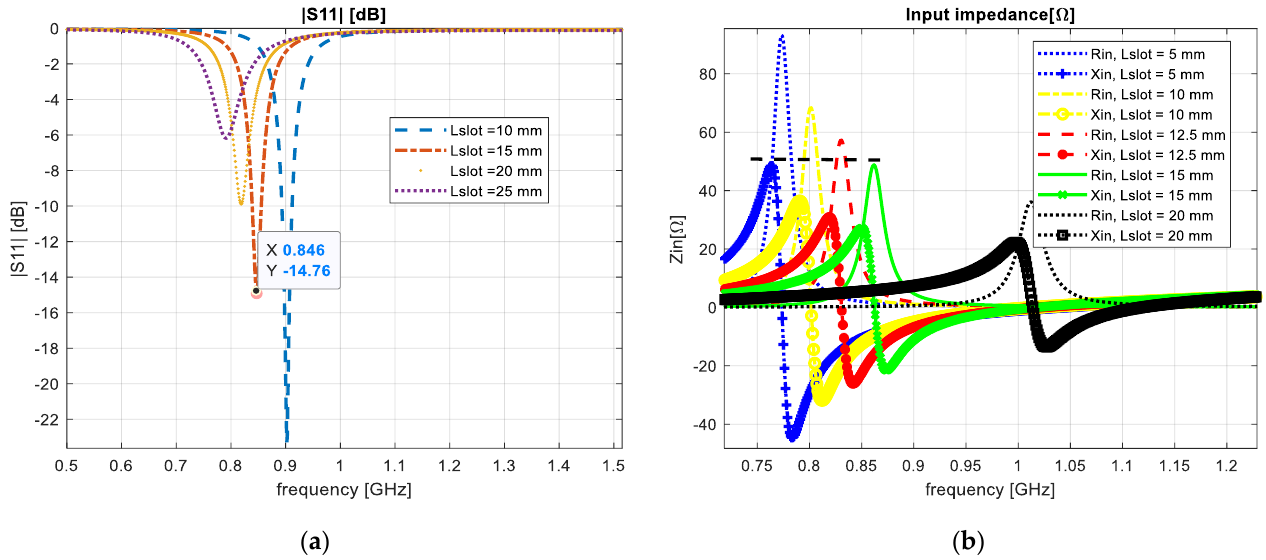
Figure 8. A centered slot integrated in the antenna design : ( a ) reflection coefficient; ( b ) input impedance.